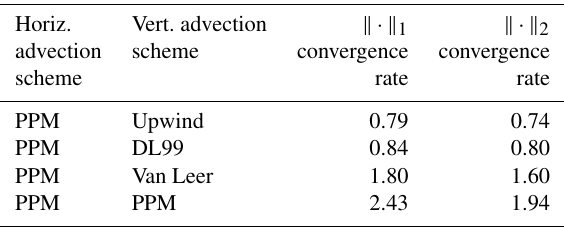
Table 5. Convergence rates in (cid:107)·(cid:107) 1 and (cid:107)·(cid:107) 2 . Horiz. Vert. advection (cid:107)·(cid:107) 1 (cid:107)·(cid:107) 2 advection scheme convergence convergence